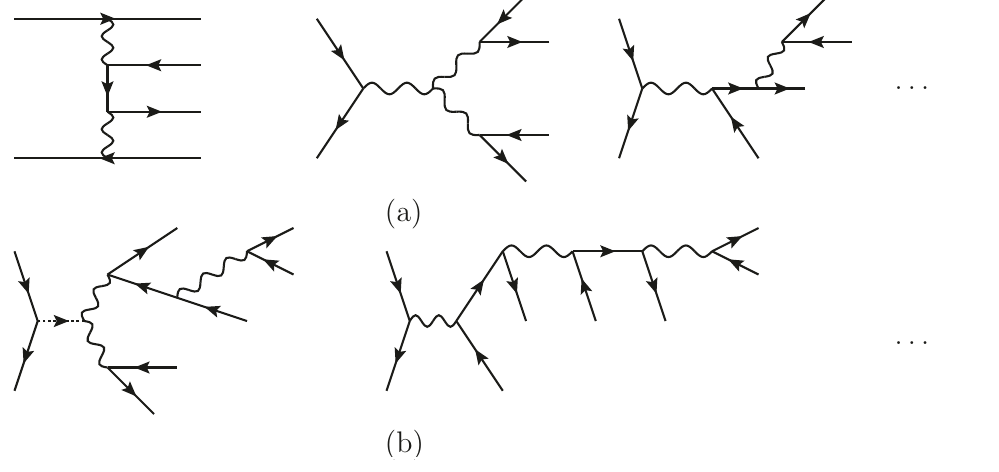
Figure 9 . The tree level Feynman diagrams of the SM contribution to the process µ + µ − → ‘ + ‘ − + / E